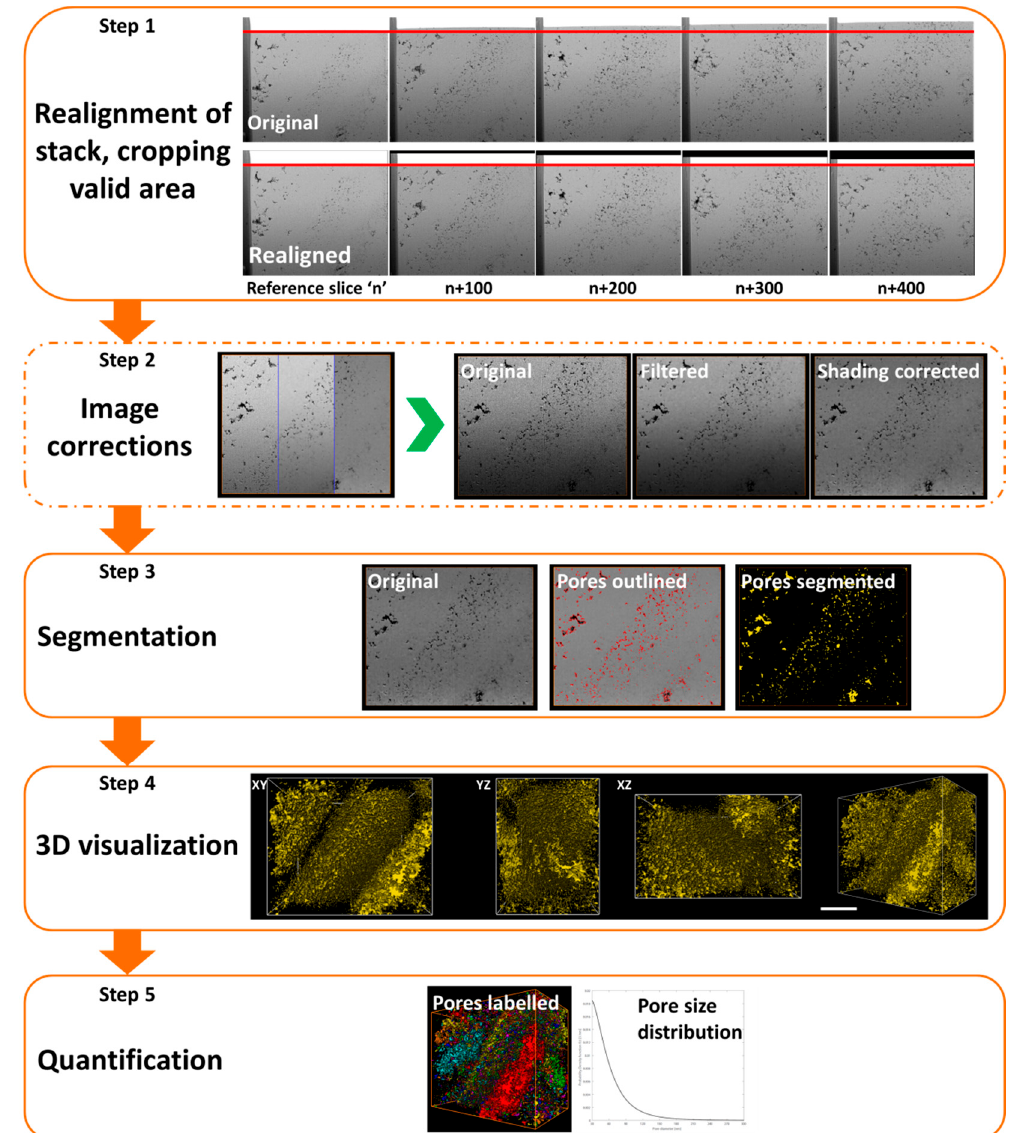
Figure 7. General steps of image processing on tomographic data from serial sectioning procedure.